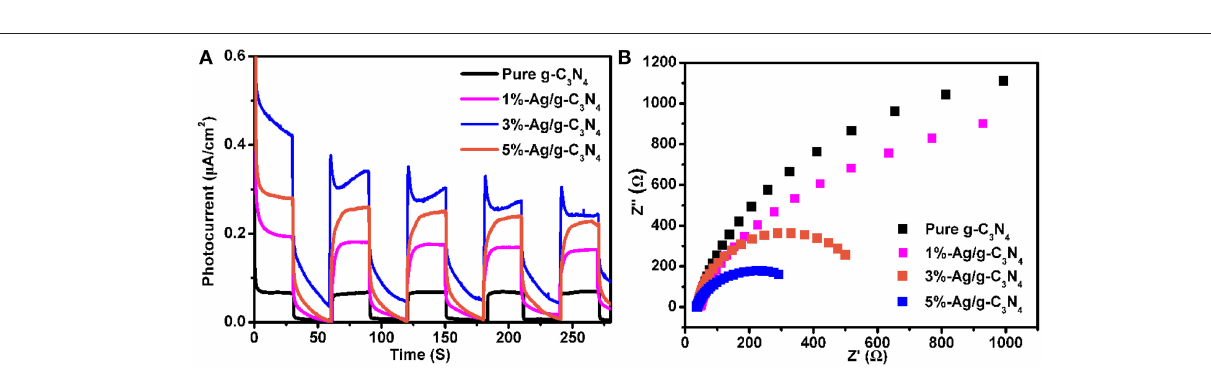
Frontiers in Chemistry |